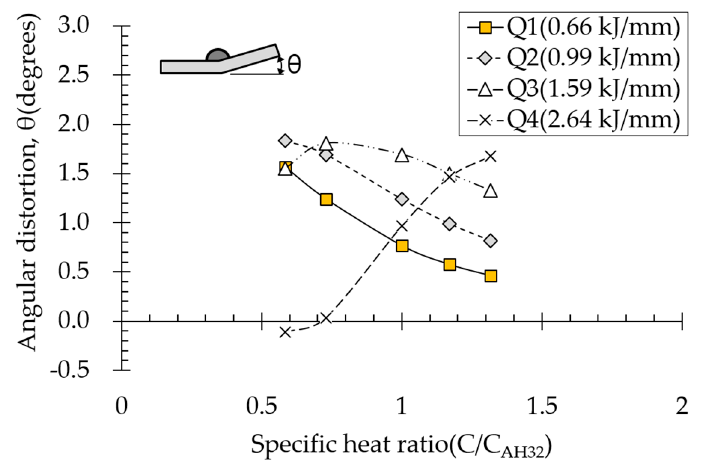
ff ect of specific heat on angular distortion. Figure 12. Effect of specific heat on angular distortion. Figure 12. E